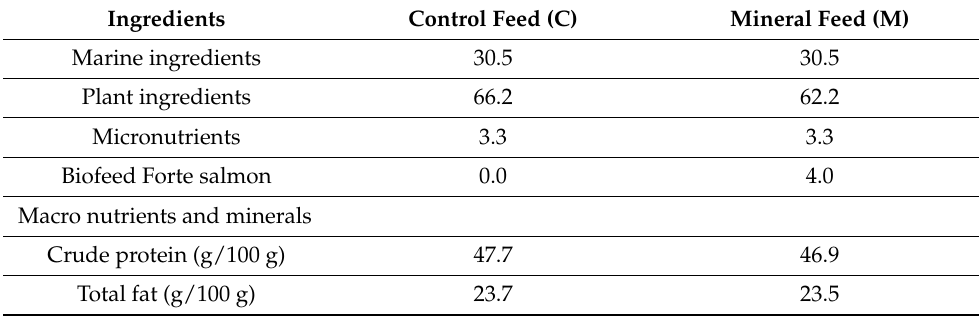
Table 1. Ingredient composition, and macro nutrients and minerals in the